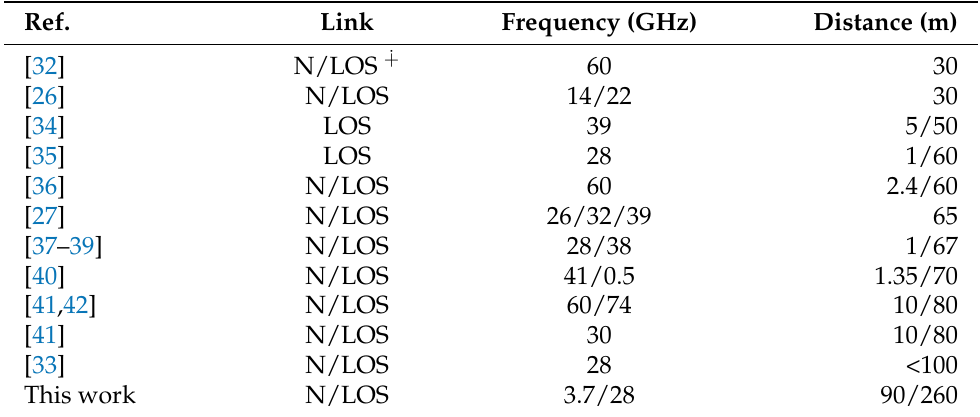
Table 1. Indoor corridor propagation study information for the path length in the corridor greater than 30